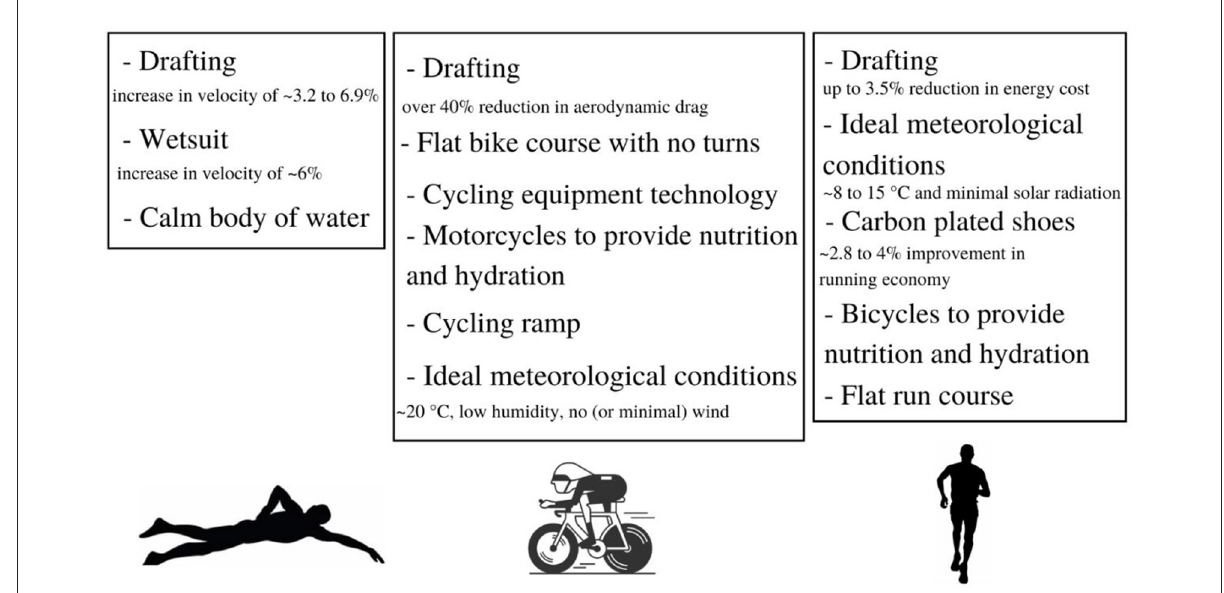
FIGURE2 Summary of the different variables that can make a sub-7 Ironman TM performance possible.